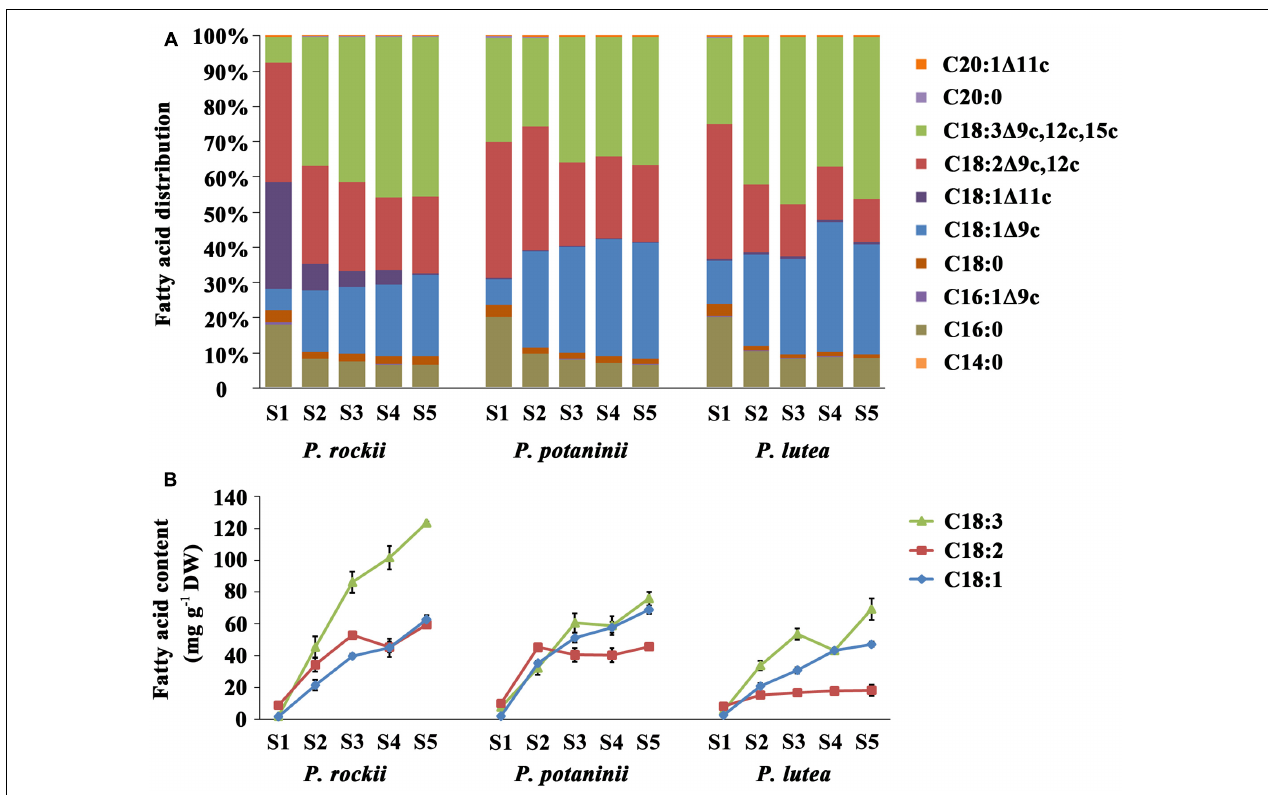
FIGURE 3 | Fatty acid composition during seed development in three wild species. Changes in the (A) proportion of various FAs, and (B) content of three major unsaturated FAs during seed development (mean ± SD, n = 3).